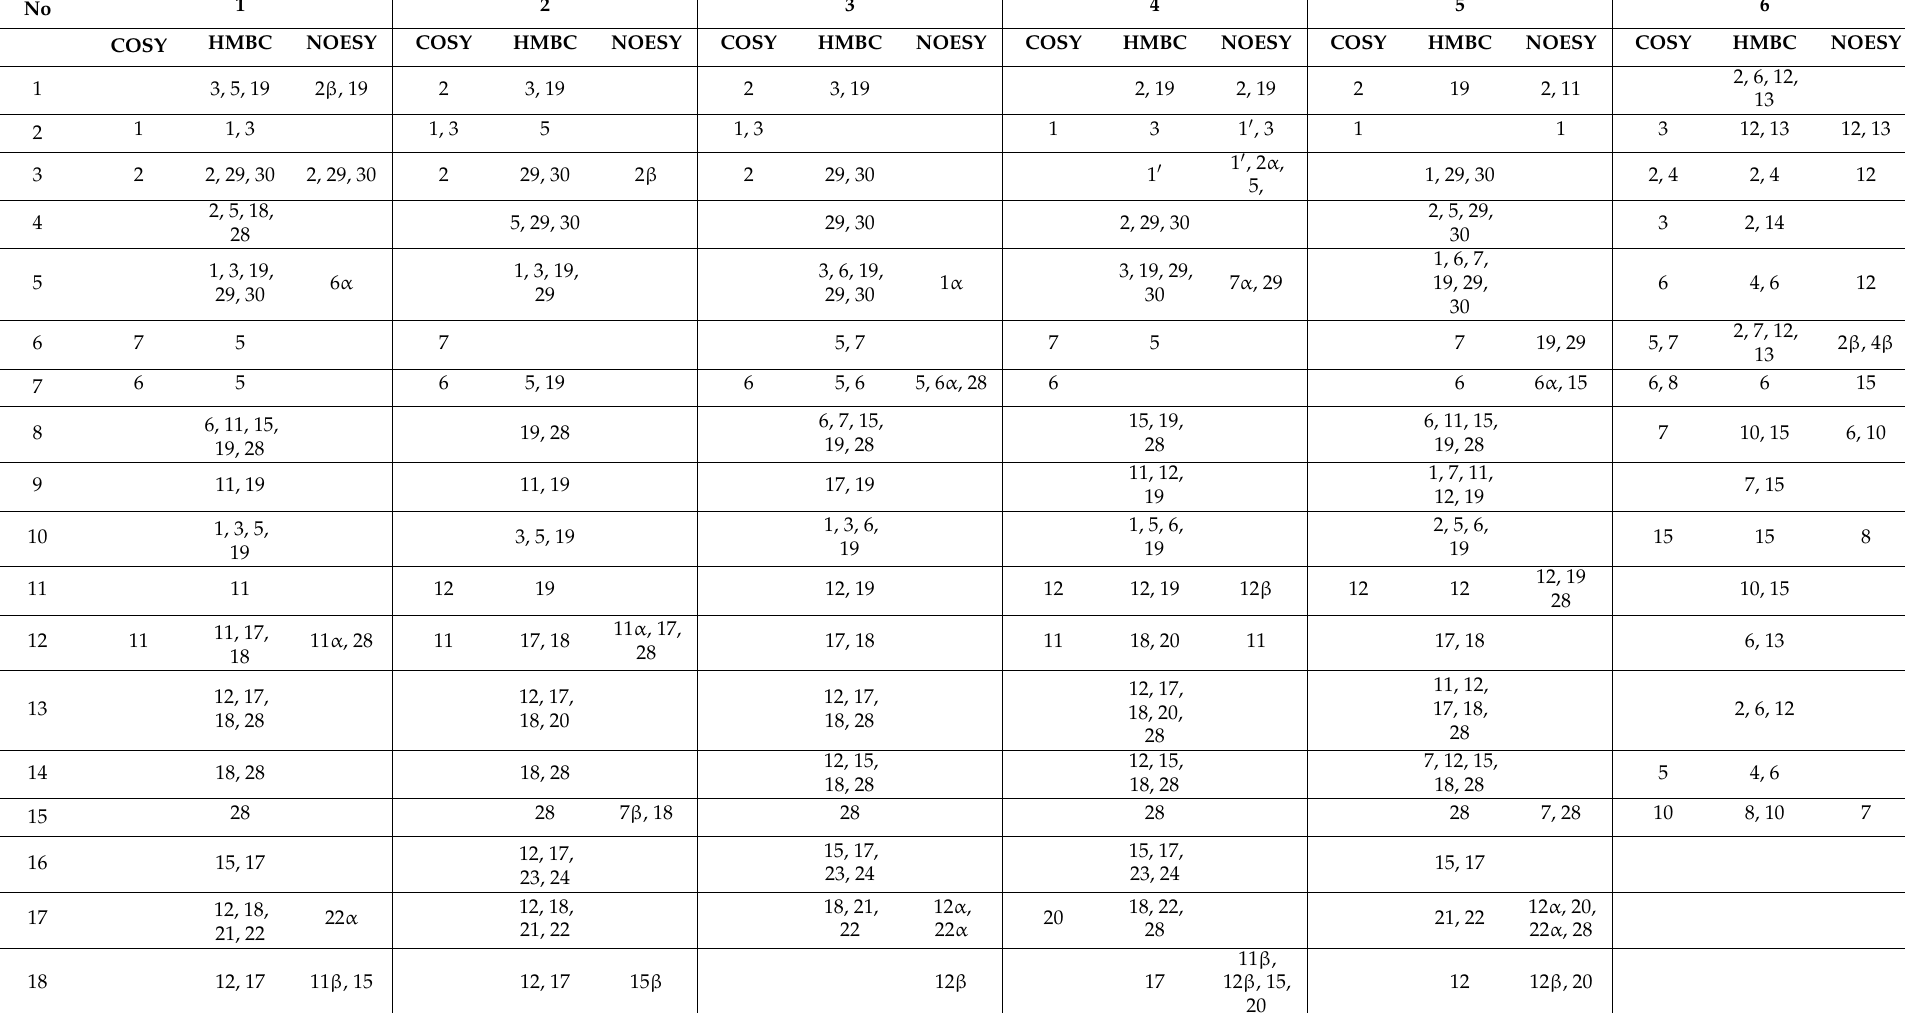
Table 3. 2D-NMR data for compounds 1 – 6 in CDCl 3 ( δ in ppm, J in Hz at 500 MHz in CDCl 3